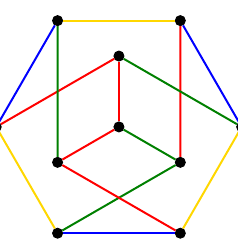
Fig. 10: The Petersen graph is a generalized Halin graph. A prism Hamiltonian decomposition using a single B-Y cycle (the generalized Halin cycle) is indicated.